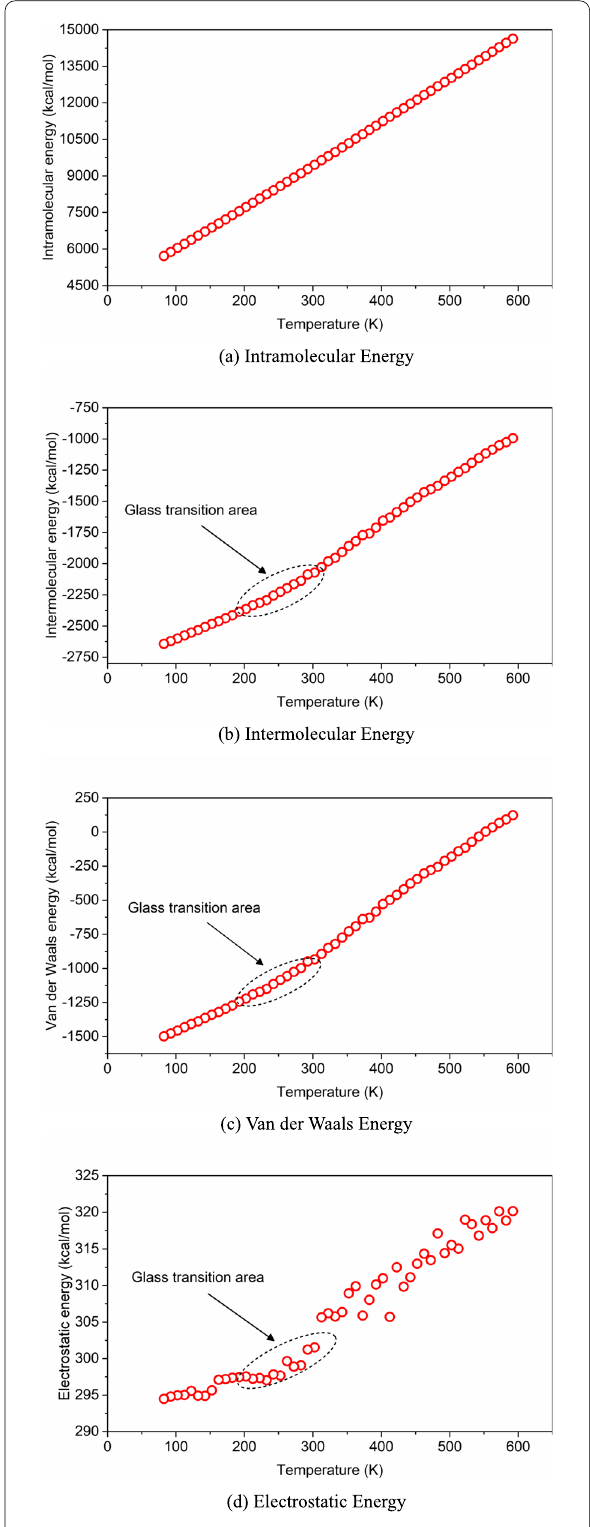
Fig. 12 Model Energies versus Temperature Diagrams for the Asphalt Models at the Temperatures from 80 to 600 K: ( a ) Intramolecular Energy, ( b ) Intermolecular Energy, ( c ) Van der Waals Energy, and ( d ) Electrostatic